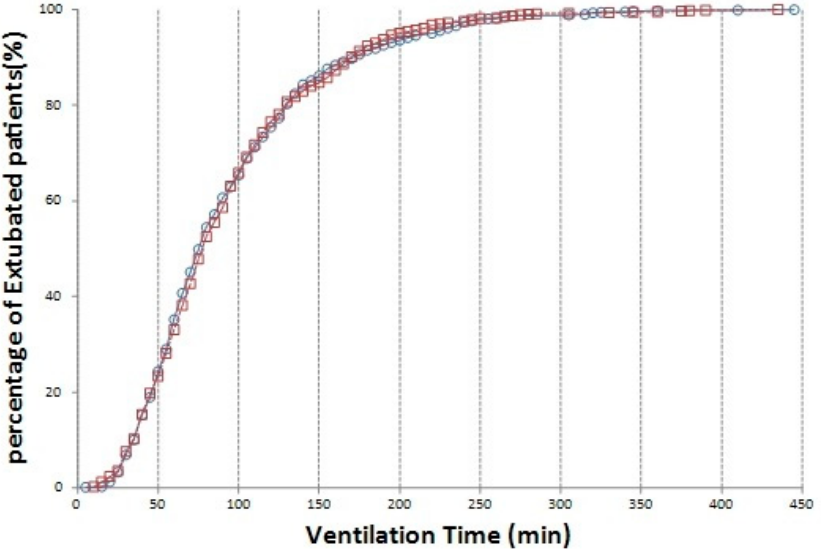
Figure 3. Comparison of ventilation time between on- (blue circles) and off-pump (red squares) group. There were no significant differences between groups in terms of PACU, IMC or hospital length of stay (Table 2). Furthermore, there was no significant difference in the Table 2. Postoperative outcome parameters for patients included in the study. Values are median (IQR (range)). primary and secondary fast-track failure in the on- compared to off-pump CABG (Table 3). Postoperative complications were also comparable, except for statistically significant differ- ences in in-PACU postoperative bleeding, which was higher for the off-pump group and a higher perioperative and in-PACU red blood cell (RBC) transfusion rate for the on-pump group (Table